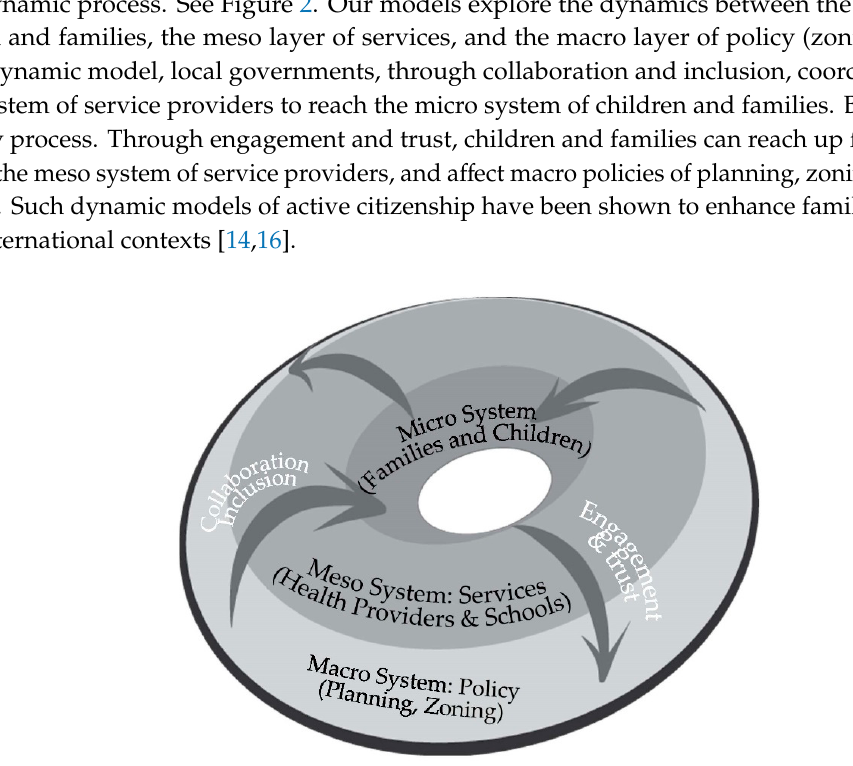
Figure 2. A Dynamic Human Ecology Framework: Healthy Places for Children.